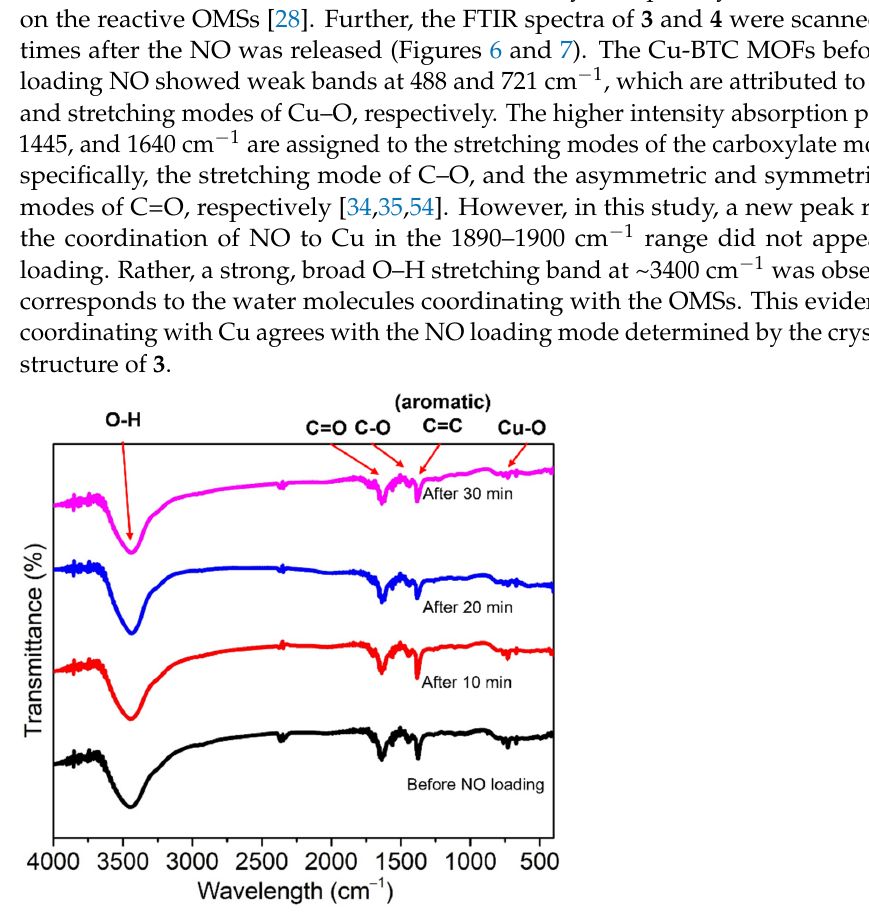
Figure 5. N 2 sorption, measured at 77 K, and pore size of 1 ( a , b ) and 2 ( c , d ).